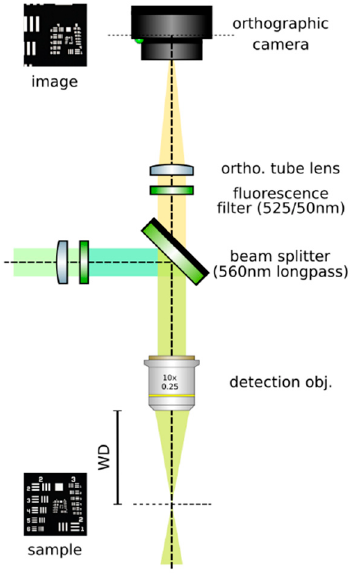
Figure 11. Image a high-contrast sample. Displace the sample until a sharp image of it appears on the orthographic camera. Figure 3. Beam expansion. Adjust the distance between the two lenses to guarantee that a collimated beam is achieved. Adjust their lateral positions so that the beam is not deviated.